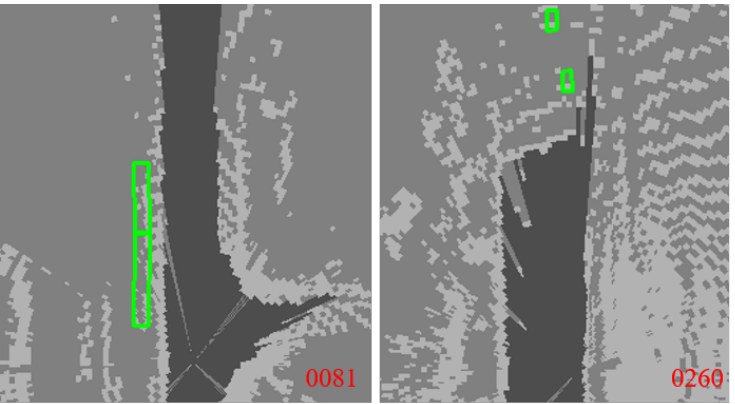
Figure 11. Judgment results of perception effectiveness: the judgment is correct. The judgment and verification are invalid after matching and verifying with the ground truth.